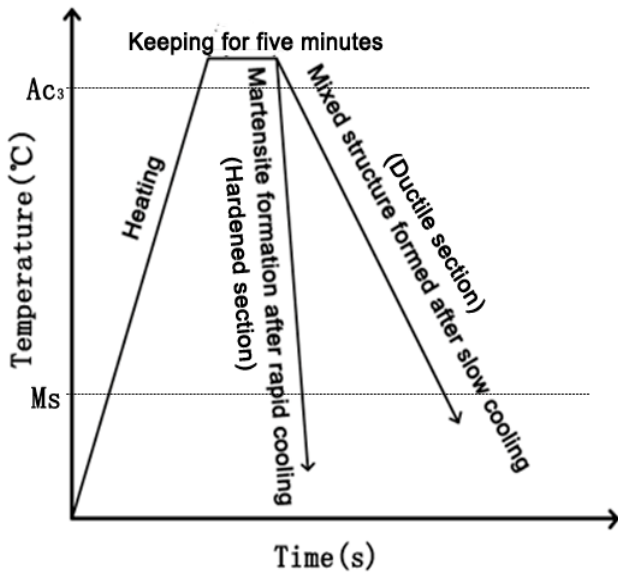
Figure 7. The schematic illustration of heat treatment of the blank.